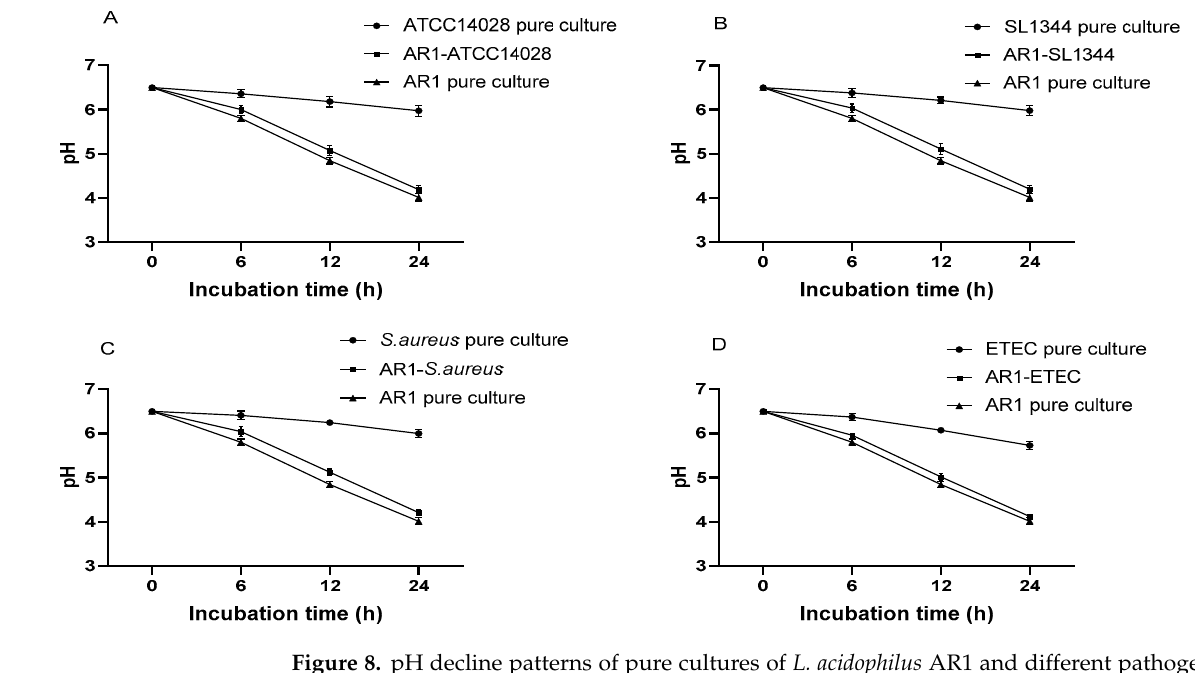
Figure 7. Growth pattern of S . Typhimurium ATCC14028 ( A ), S . Typhimurium SL1344 ( B ), S. aureus ( C ), and ETEC ( D ) in pure and co-culture with different Lactobacilli .